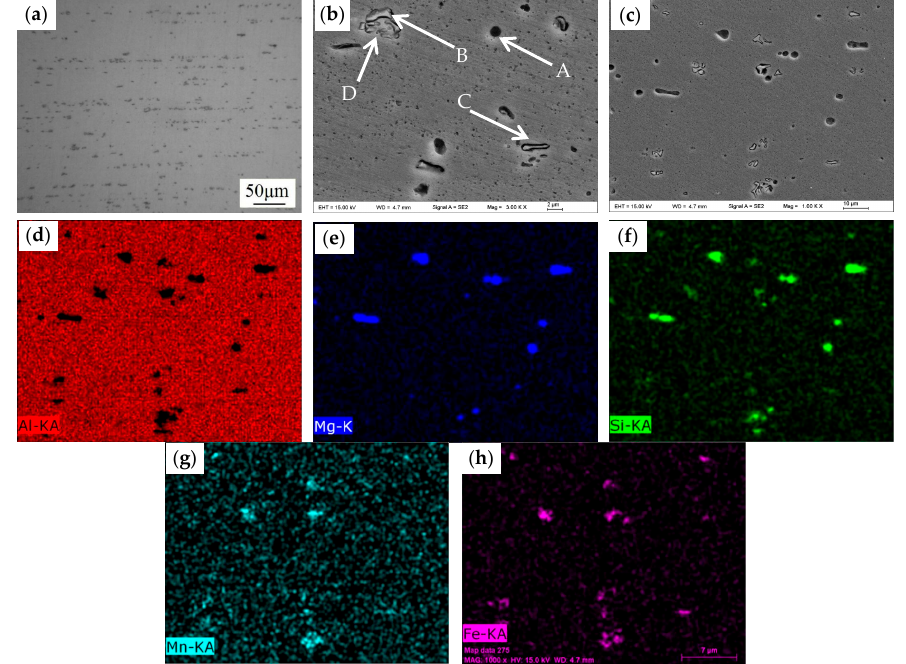
Figure 9. ( a ) Optical image of original 6082-T6 base metal; ( b ) SEM image of the frail position in HAZ of welded joint No. 7, 3784.4 kJ; SEM image and energy dispersion X-ray (EDX) maps of elements of the frail position in HAZ of welded joint No. 2, 5791.8 kJ: ( c ) SEM microstructure; ( d ) Al; ( e ) Mg; ( f ) Si; ( g ) Mn; ( h )